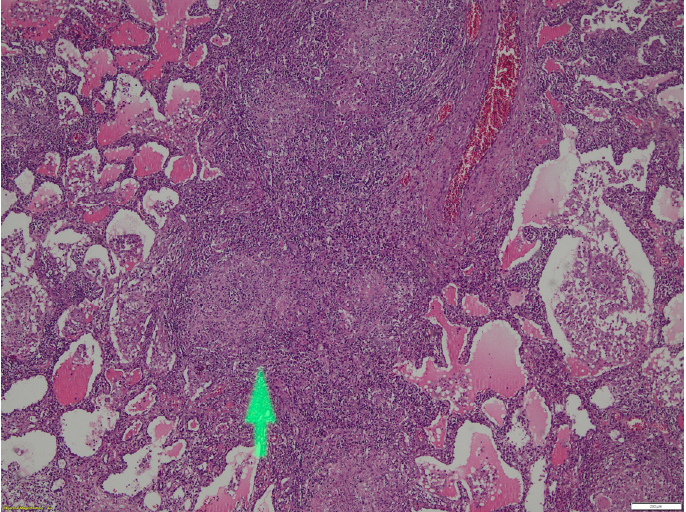
Figure 2. Microscopy imaging, hematoxylin–eosin staining, magnification 4×. The arrow shows the presence of non-caseous granulomatous inflammation with multinucleated giant cells, epithelioid histiocytes, an infiltrate of lymphocytes.